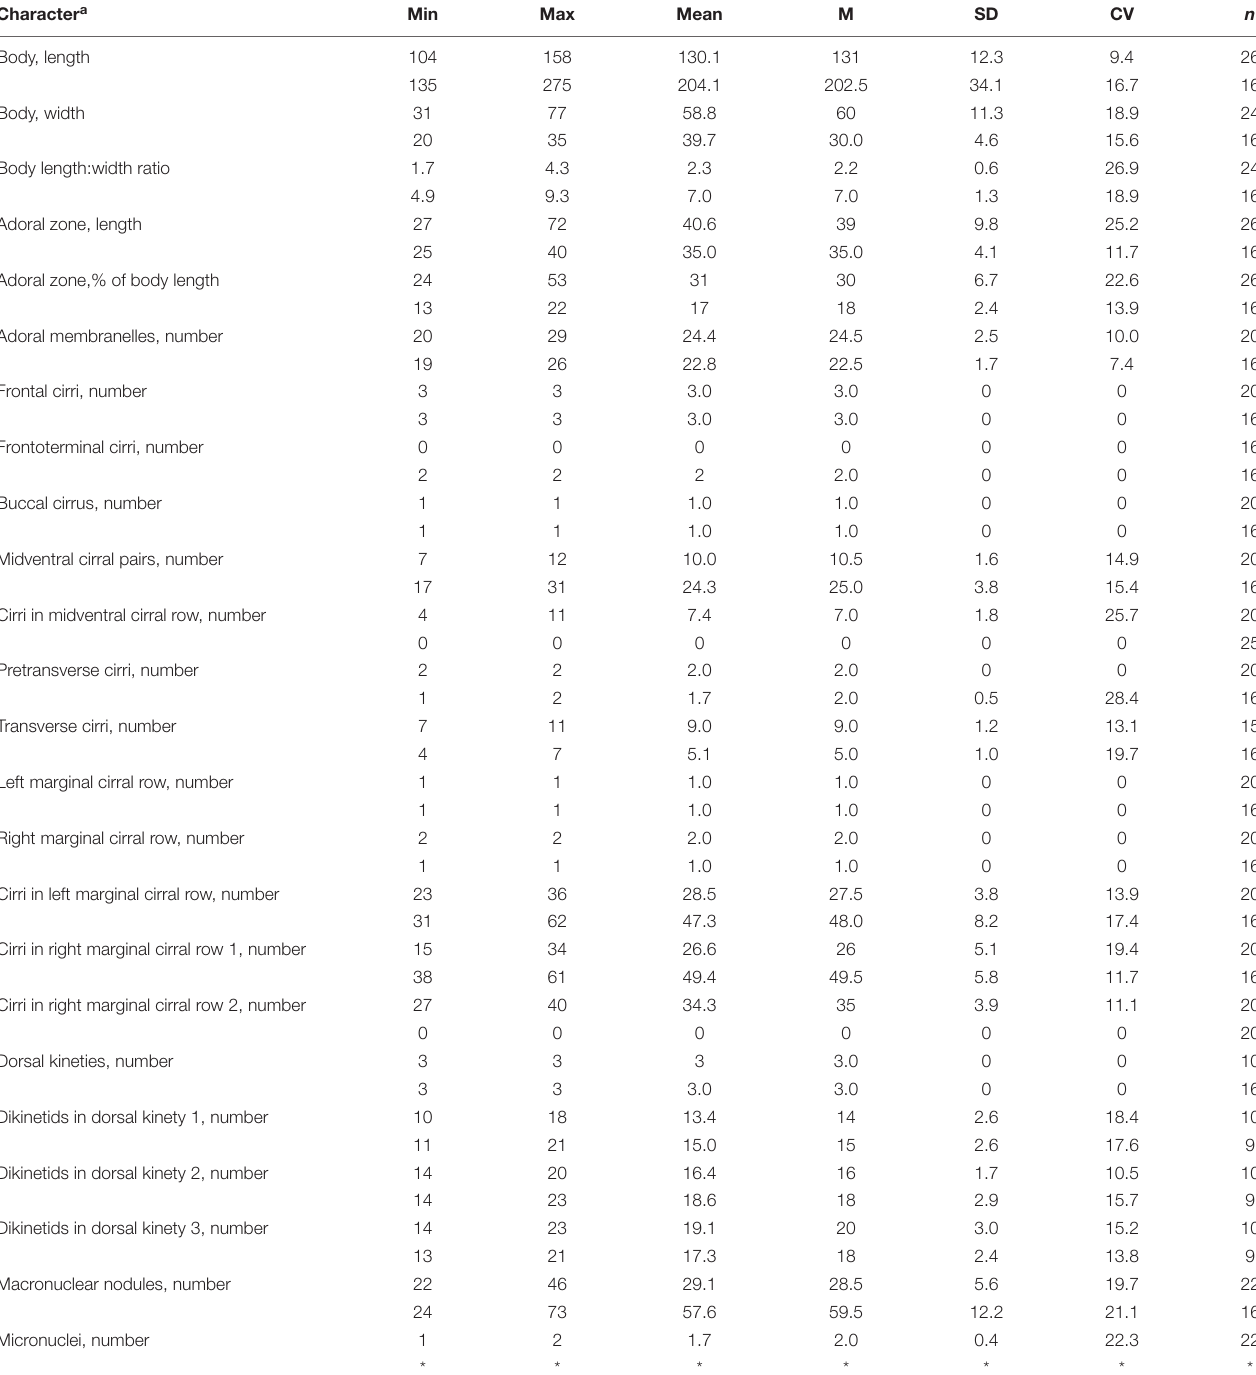
TABLE 1 | Morphometric characterizations of Heterobakuella bergeri gen. nov., sp. nov. (upper line) and Anteholosticha perezuzae sp. nov. (lower